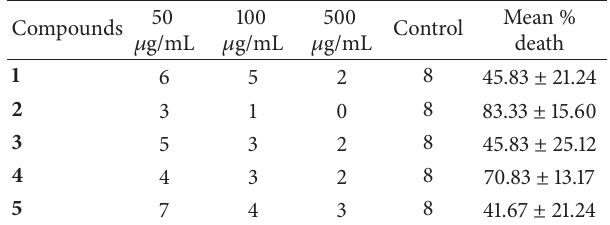
Table 3: The number of surviving shrimps after 24 hours incubation in the complexes and